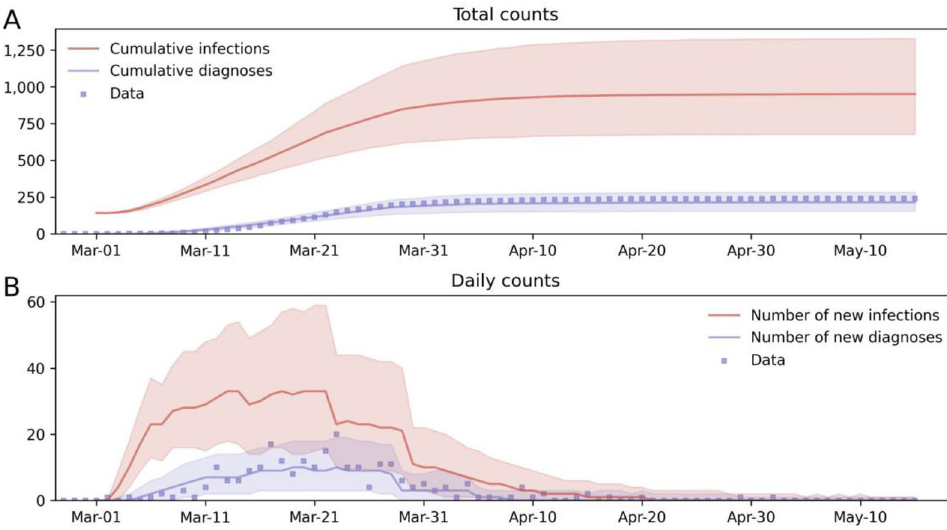
Figure 1. Fitting of the calibrated model to the main COVID-19 wave in Queensland between 1 March 2020 and 15 May 2020. ( A ) Cumulative trajectories. ( B ) Daily trajectories. Solid lines are the median model projections over 1000 model runs; shaded areas indicate 95% projected intervals over different initialisations of infected agents on 1 March 2020; blue dots represent empirical numbers of confirmed locally-acquired